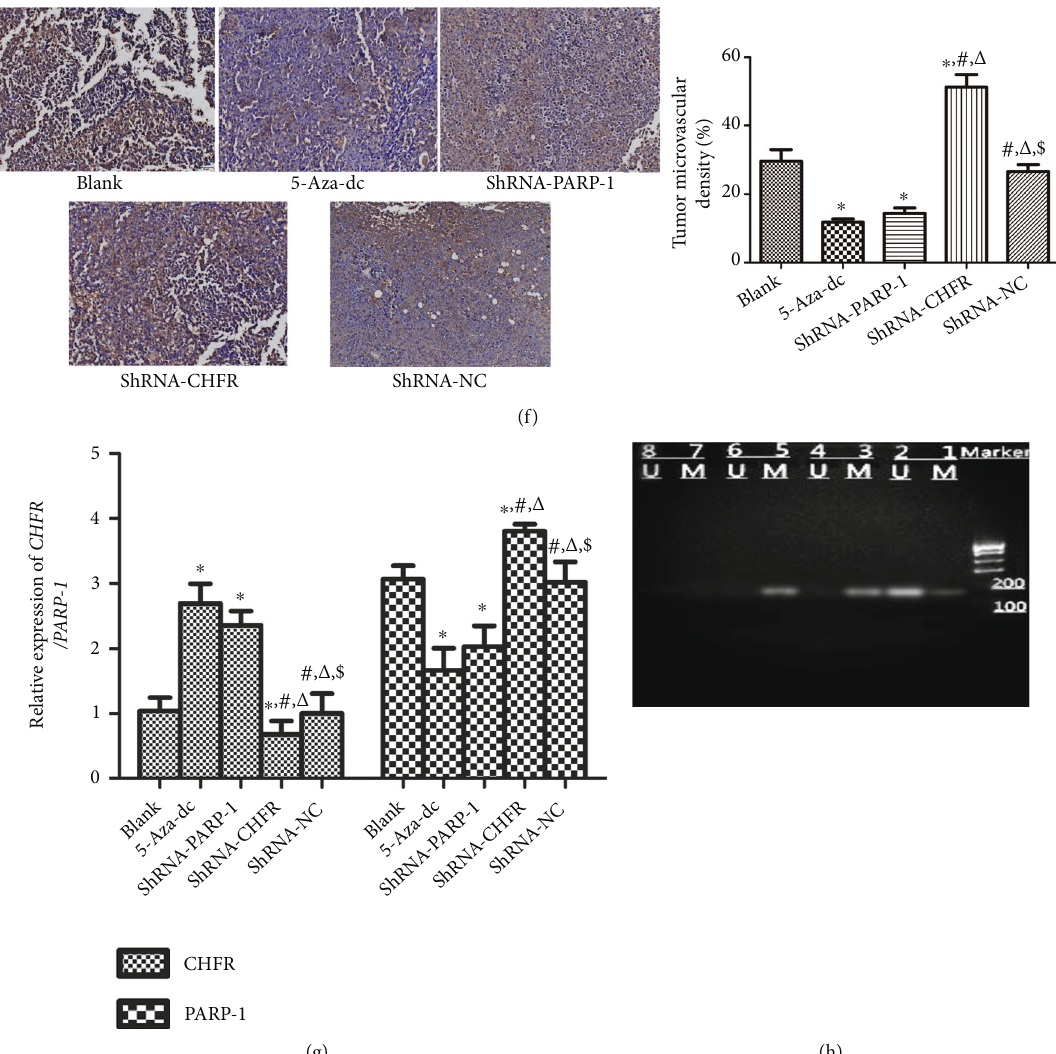
Figure 6: The e ff ects of CHFR and PARP-1 on the tumor xenograft model in vivo. The nude mice were injected with the cell suspension with di ff erent treatment for 24 hours. (a) The tumor size in di ff erent groups after fed for 24 days. ((A) Normal mice, mice without treatment; (B) 5-Aza-dC group, mice injected with 5-Aza-dc-treated cell suspension; (C) ShRNA-PARP-1 group, mice injected with sh-PARP-1- transfected cell suspension; (D) blank group, mice injected with PBS cell suspension; (E) ShRNA-CHFR group, mice injected with sh- CHFR-transfected cell suspension; and (F) ShRNA-NC group, mice injected with sh-NC-transfected cell suspension). (b) Tumor dissection in each group. (c) Tumor growth curves in the mice of the blank, 5-Aza-dc, ShRNA-PARP-1, ShRNA-CHFR, and ShRNA-NC groups. (d) The tumor volume and weight in the mice of the di ff erent groups. (e) Cell apoptosis rate in tumors of the di ff erent groups. (f) Tumor microvascular density in the di ff erent groups. (g) The mRNA expression levels of CHFR and PARP-1 in the di ff erent groups. (h) Determination of methylation of CHFR in mice using MSP (M: methylation; U: Unmethylation; 1, 2: treatment group, the Raji cells- induced mice treated with 5-Aza-Dc; 3, 4: control group, the Raji cells-induced mice with PBS; 5, 6: positive control group, the normal peripheral blood treated with SssI methyl transferase; and 7, 8: blank control group, the normal mice). * P < 0 : 05 , compared with the blank group. # P < 0 : 05 , compared with the 5-Aza-dc group. △ P < 0 : 05 , compared with the ShRNA-PARP-1 group. $ P < 0 : 05 , compared with the ShRNA-CHFR